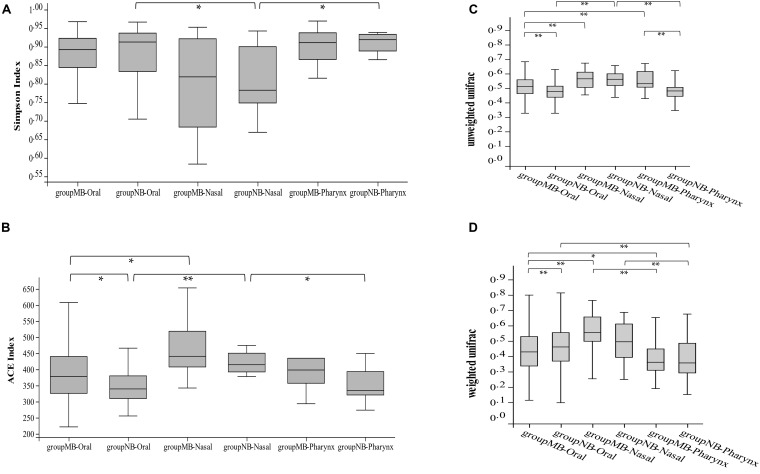
The comparison of (A) Simpson and (B) ACE indices of bacterial community of oral–nasal–pharyngeal samples among the mouth-breathing (MB) and nose-breathing (NB) groups; the comparison of (C) unweighted UniFrac and (D) weighted UniFrac analysis of bacterial community of oral–nasal–pharyngeal samples among the MB and NB groups; *p < 0.05, **p < 0.001.